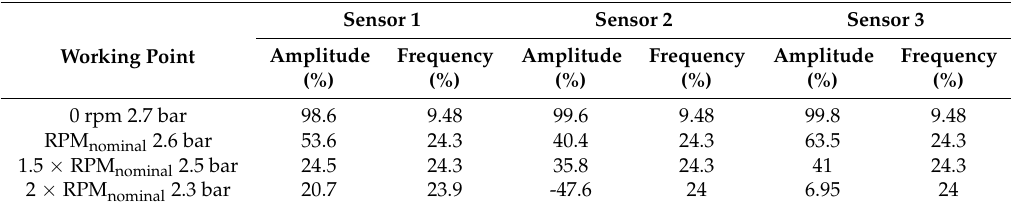
Table 10. Reduction in amplitude and frequency vibration in the second prototype for each optical